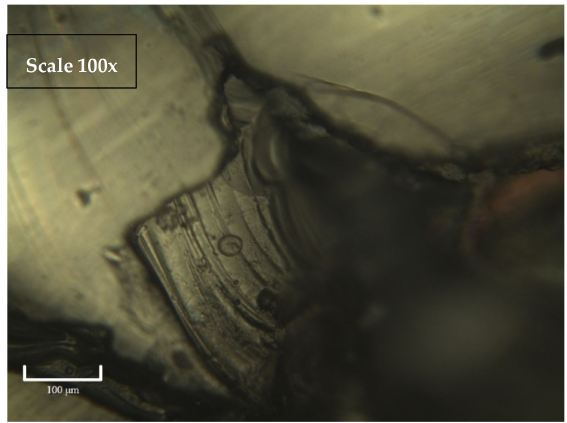
Figure 17. Partial removal of the sapphire in the lower